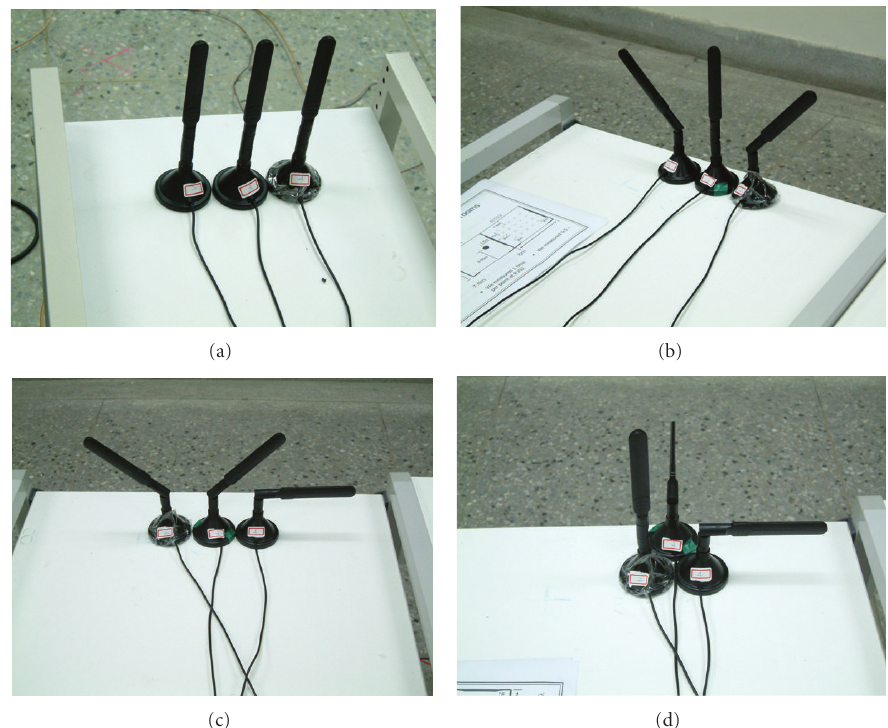
Figure 5: Photos of the four di ff erent polarization combinations denoted as (a) VVV, (b) YVY, (c) YYH, and (d) VHH in practical measurement